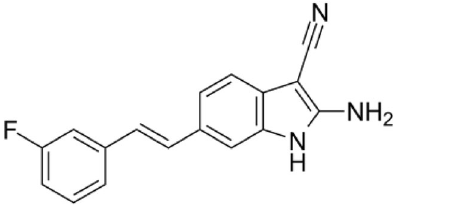
Fig. 4 The structure of GSK2643943A. The structure of GSK2643943A, one small molecule inhibitor for